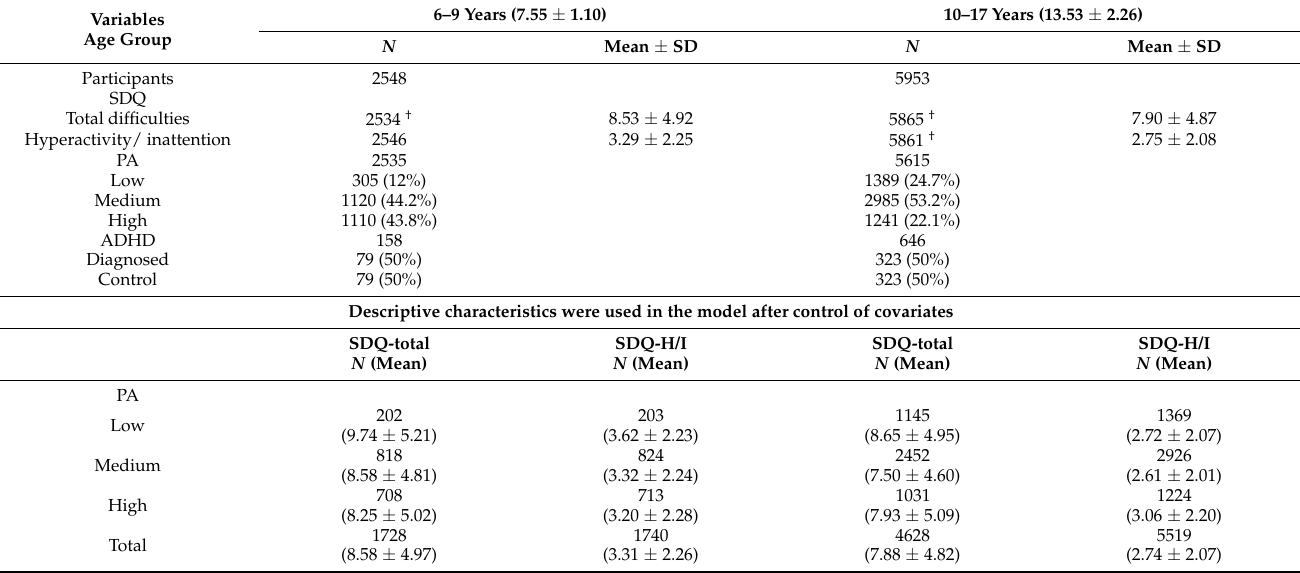
Table 2. Descriptive characteristics of the study population at wave 1.